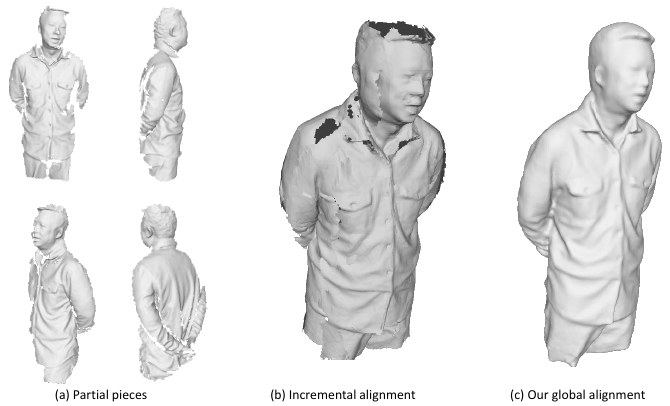
Figure 6. Illustration of drifting effect of incremental alignment and comparison with the result after our global registration. ( a ) some sampled partial pieces; ( b ) the result from incremental alignment where large gaps exist; ( c ) the result after global